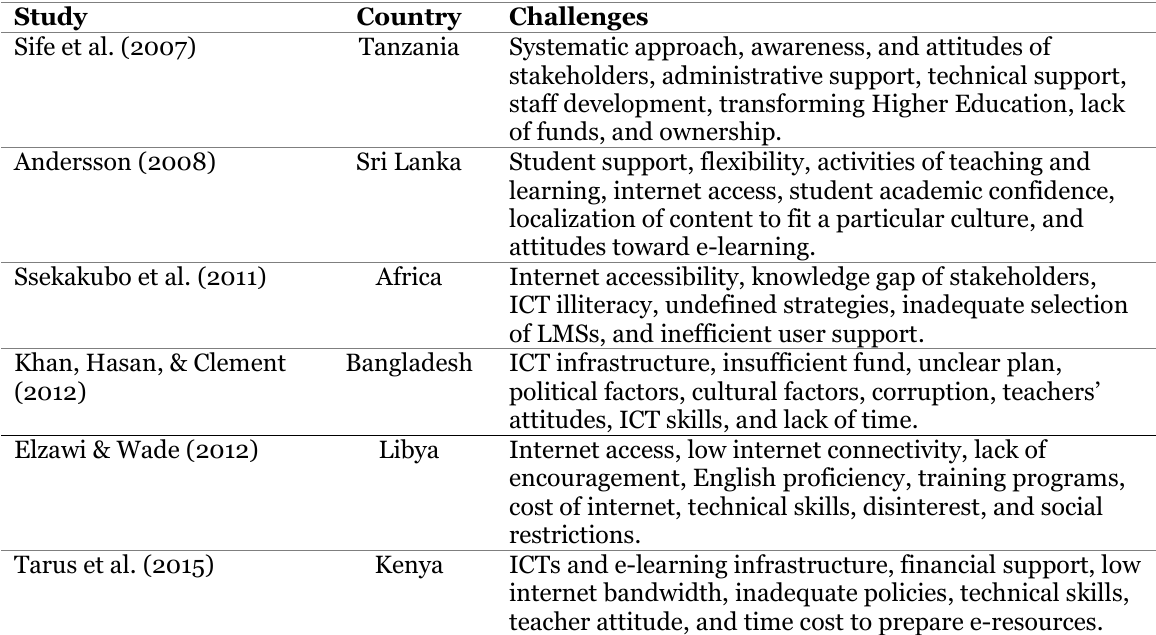
Challenges Hindering E-Learning Uptake in Developing Countries Study